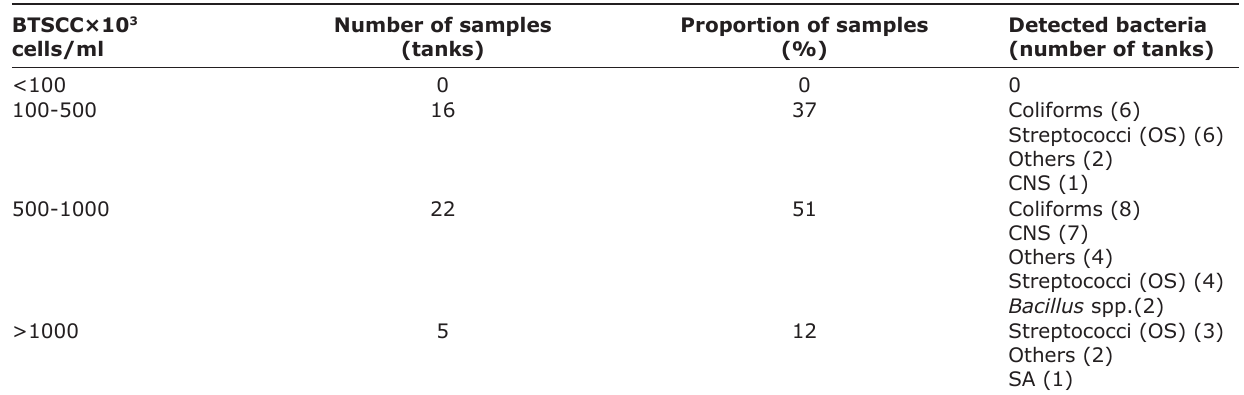
Table-3: Proportion and number of BTSCC.